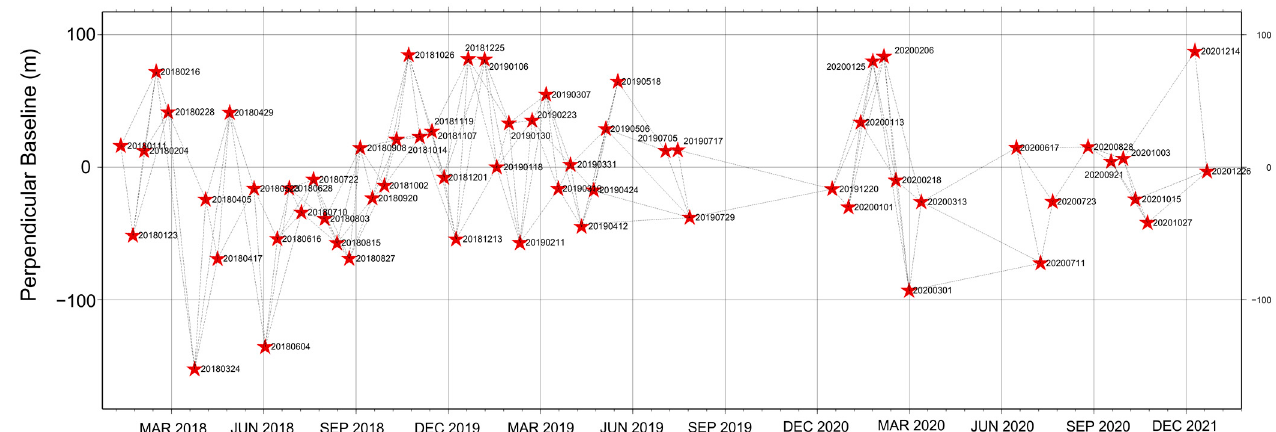
Figure 6. The small baseline network of descending datasets (the pentagram represents each SAR image).